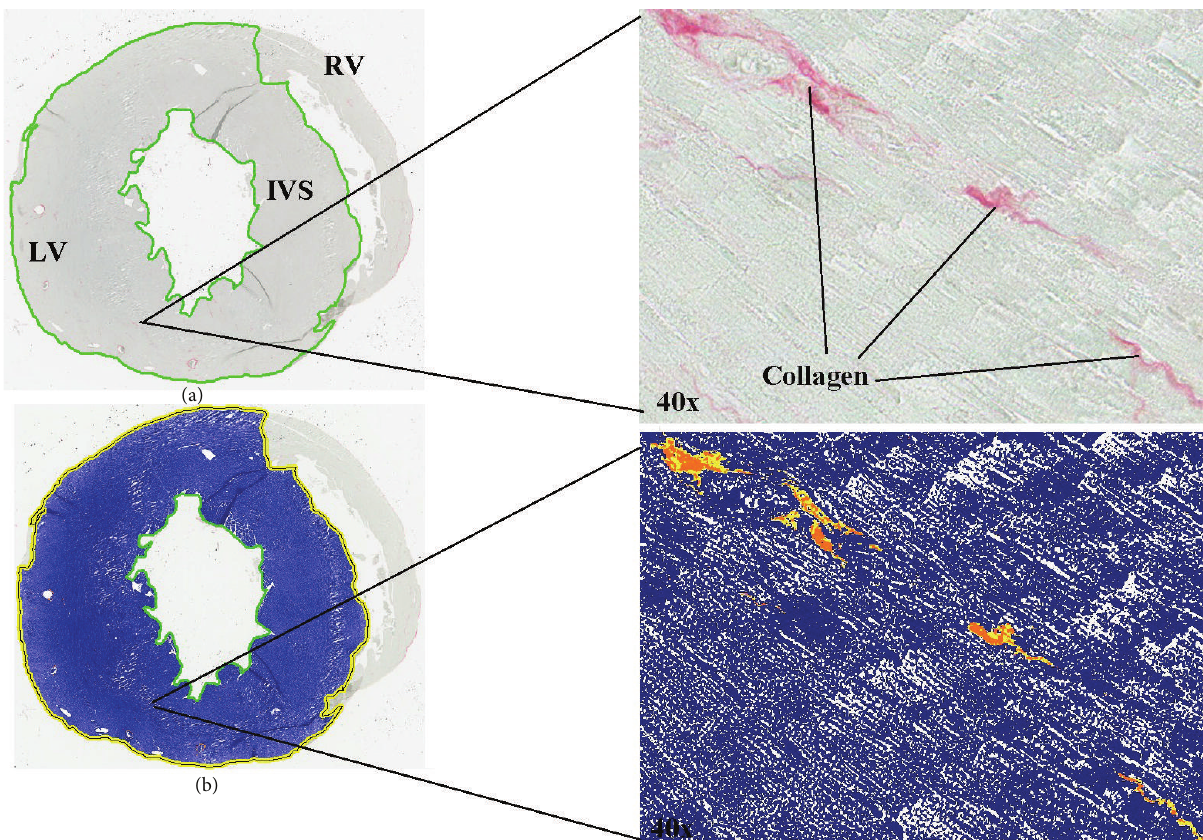
Figure 1: Histological images of six-week-old offspring of type 1 diabetic mouse demonstrating the application of the Aperio software. (a) Full image taken with Aperio digital scanning microscope. LV: left ventricle wall; RV: right ventricle wall; IVS: interventricular septum. (b) Mark-up image showing the detection of collagen by the Aperio positive pixel count algorithm. Blue represents negative background and yellow/orange represents positive collagen detection, as shown in corresponding 40x magnified